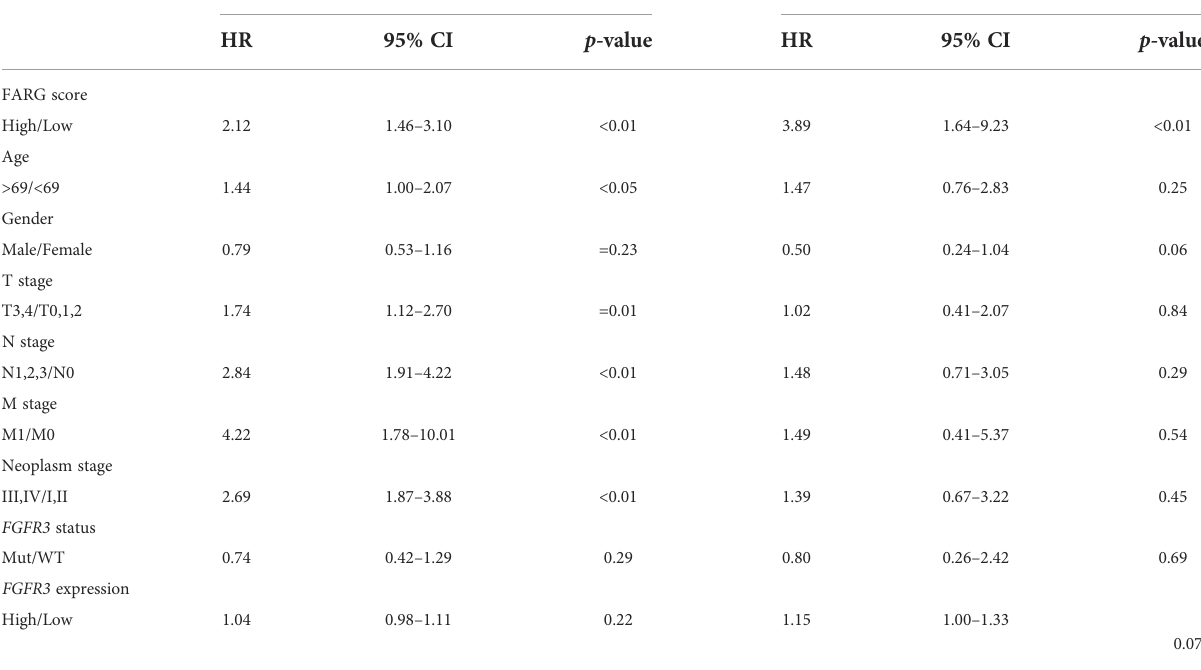
TABLE 2 Univariate and multivariate Cox regression analysis of the FARG signature and clinical features and OS of BC patients from TCGA.